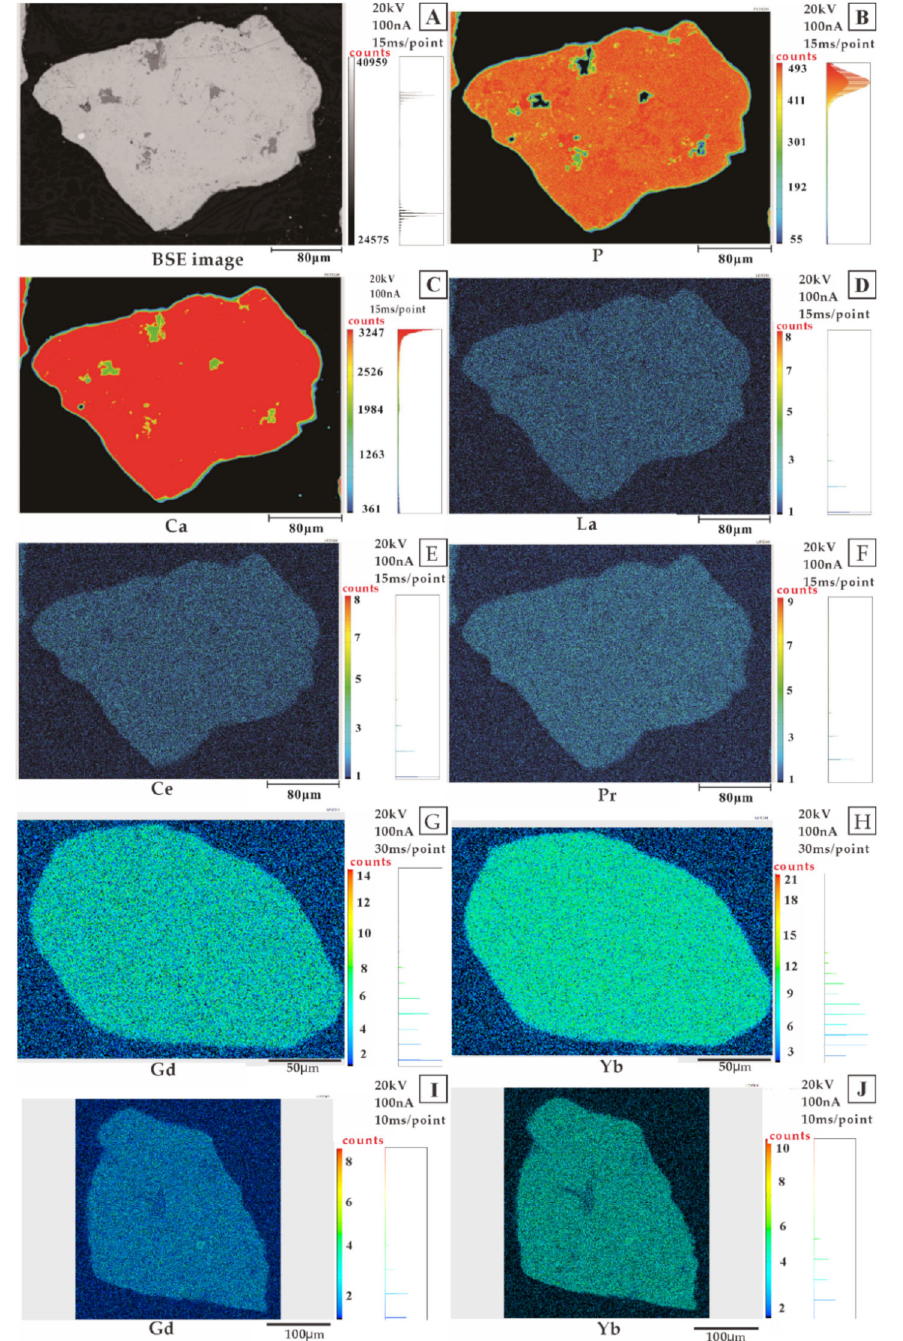
Figure 4. The EPMA Mapping analysis, ( A ) Electron back scattered di ff raction (BSE) picture of the intraclastic apatite(M20); ( B , C ) P and Ca Mapping of the intraclastic apatite(M20); ( D – F ) La, Ce and Pr Mapping of M20; ( G , H ) Gd, Yb Mapping of M11; ( I , J ) Gd, Yb Mapping of